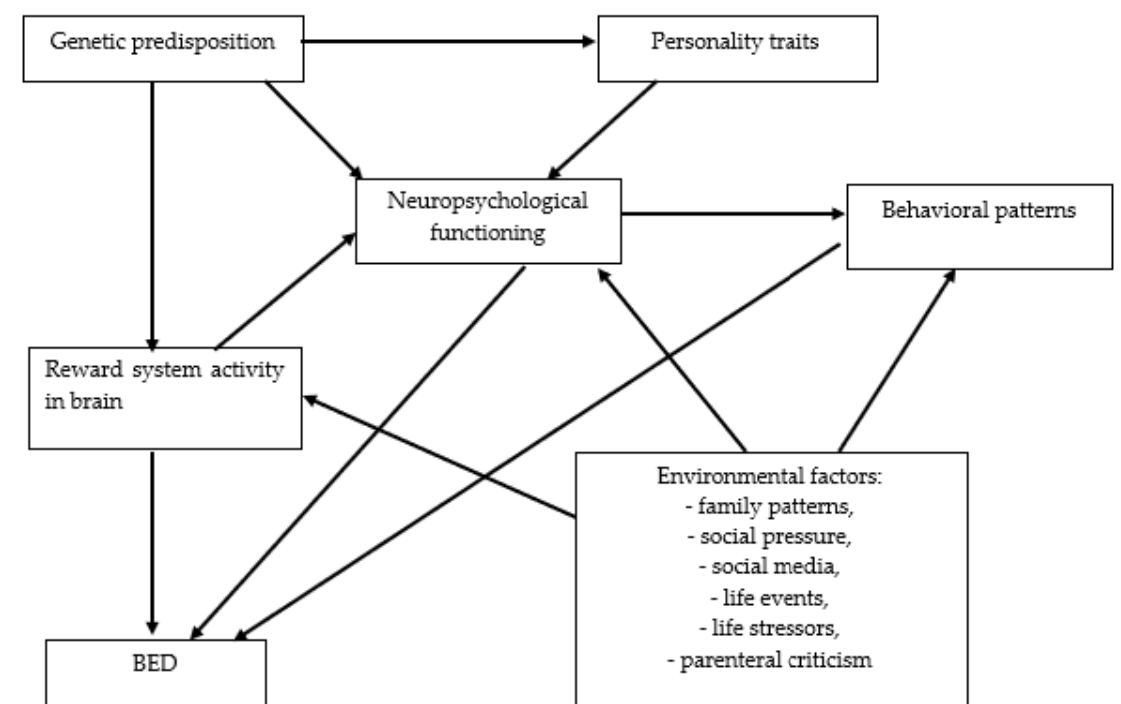
Figure 4. The network of relationships between risk factors for the development of BED. BED: binge eating disorder.